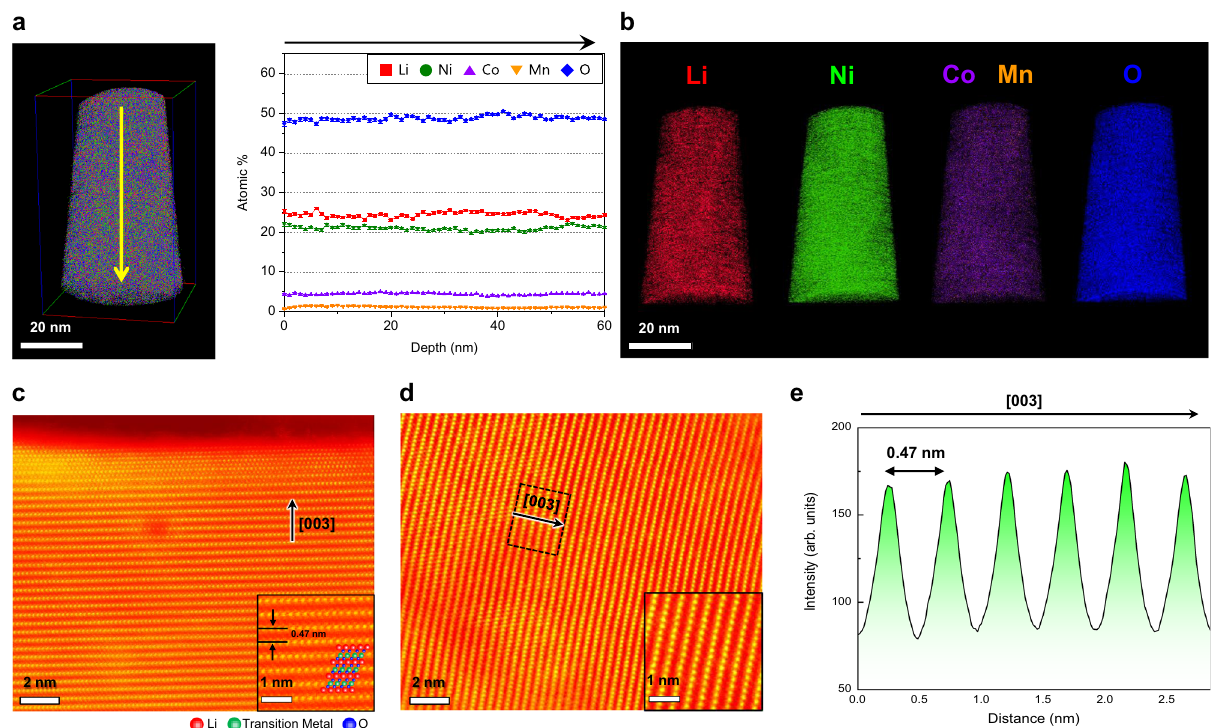
Fig. 2 Homogenous distribution of Li and the layered structure in NCM-pristine. a APT depth pro fi le showing a homogeneous distribution of the constituent elements, including Li, along the depth. b APT 3D ion map of Li (red), Ni (green), Co (violet), Mn (orange), O (blue), respectively, showing no elemental segregation. Error bars show the standard deviation of each dataset. c , d STEM-HAADF images along [1 (cid:1) 10] zone axis. A layered structure is clearly observed both at the surface ( c ) and in the interior (inset: magni fi ed image) ( d ). e HAADF intensity pro fi le along the region enclosed by the dotted square in ( d ), which shows the absence of TM